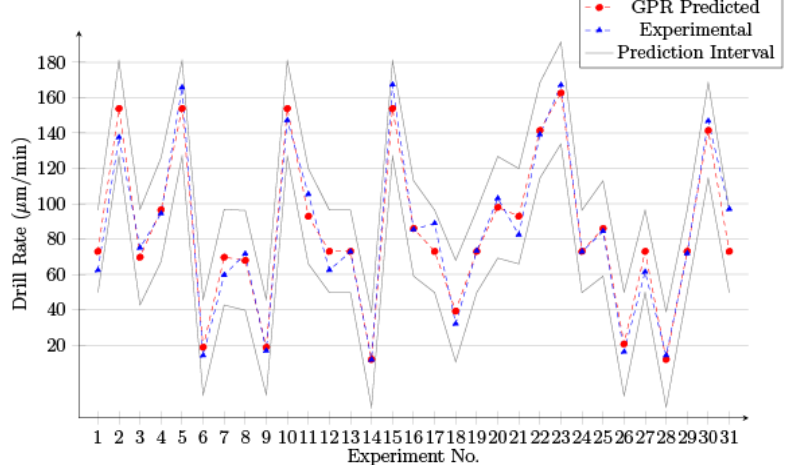
Figure 8. Experimental and GRNN predicted values for DR.